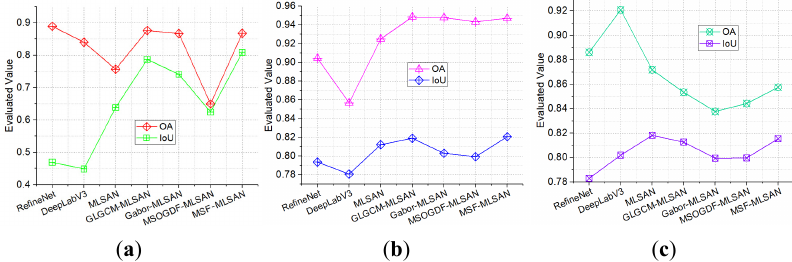
Figure 18. Classification accuracy for the four types of targets by different methods for the second experiment. ( a ) Water. ( b ) Shadow. ( c ) Background .